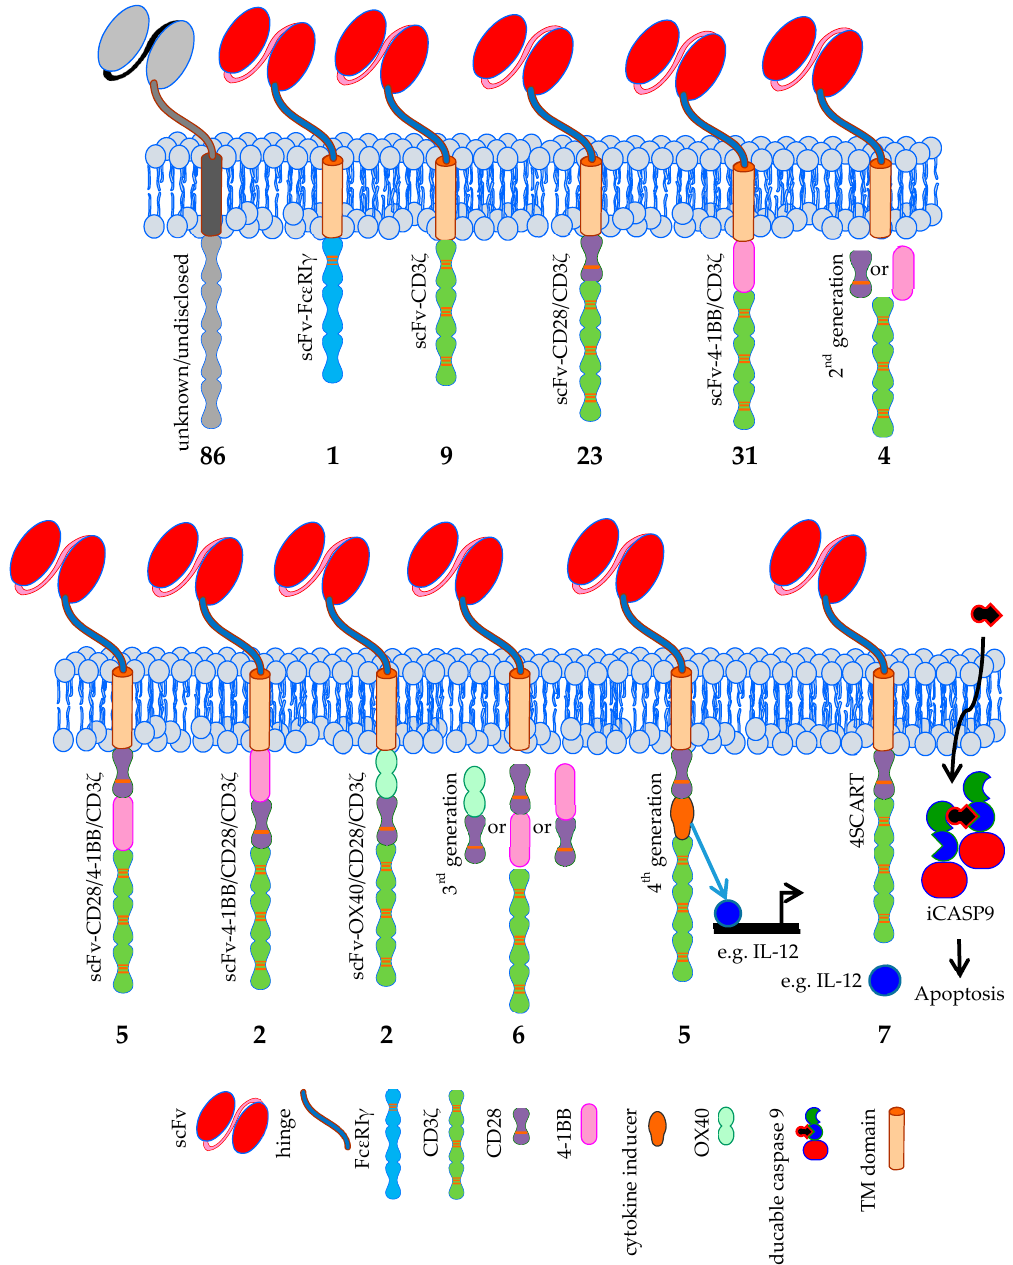
Figure 5. Schematic overview of the classical CAR formats used in clinical trials treating solid tumors. The number of clinical trials using a specific CAR format is indicated. Data was extracted from clinicaltrials.gov. TM = transmembrane domain, iCASP9 = inducible caspase 9, 4SCART = fourth generation safety CAR-T cells. The Motifolio Scientific Illustration Toolkit was used for the generation of parts of this figure.